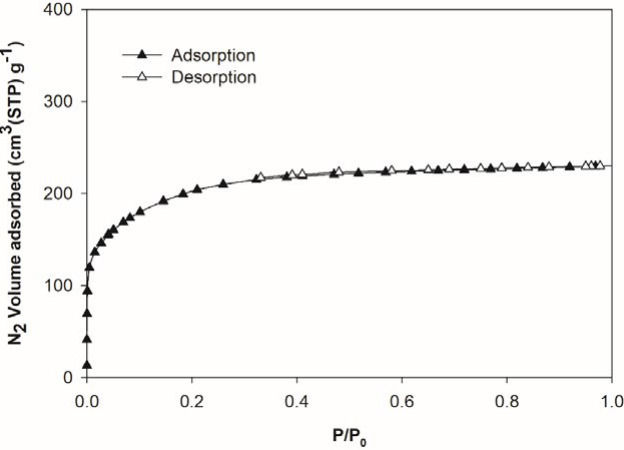
Fig. 4 Adsorption/desorption isotherms of N 2 for NDC.